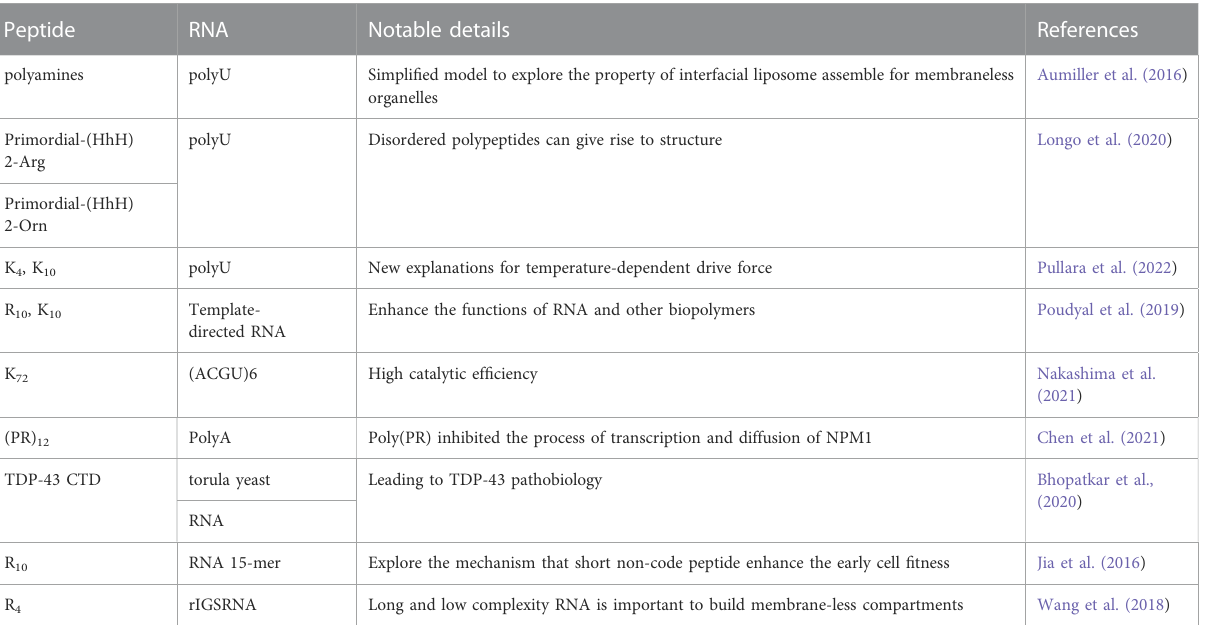
TABLE 4 Summary of peptide-RNA